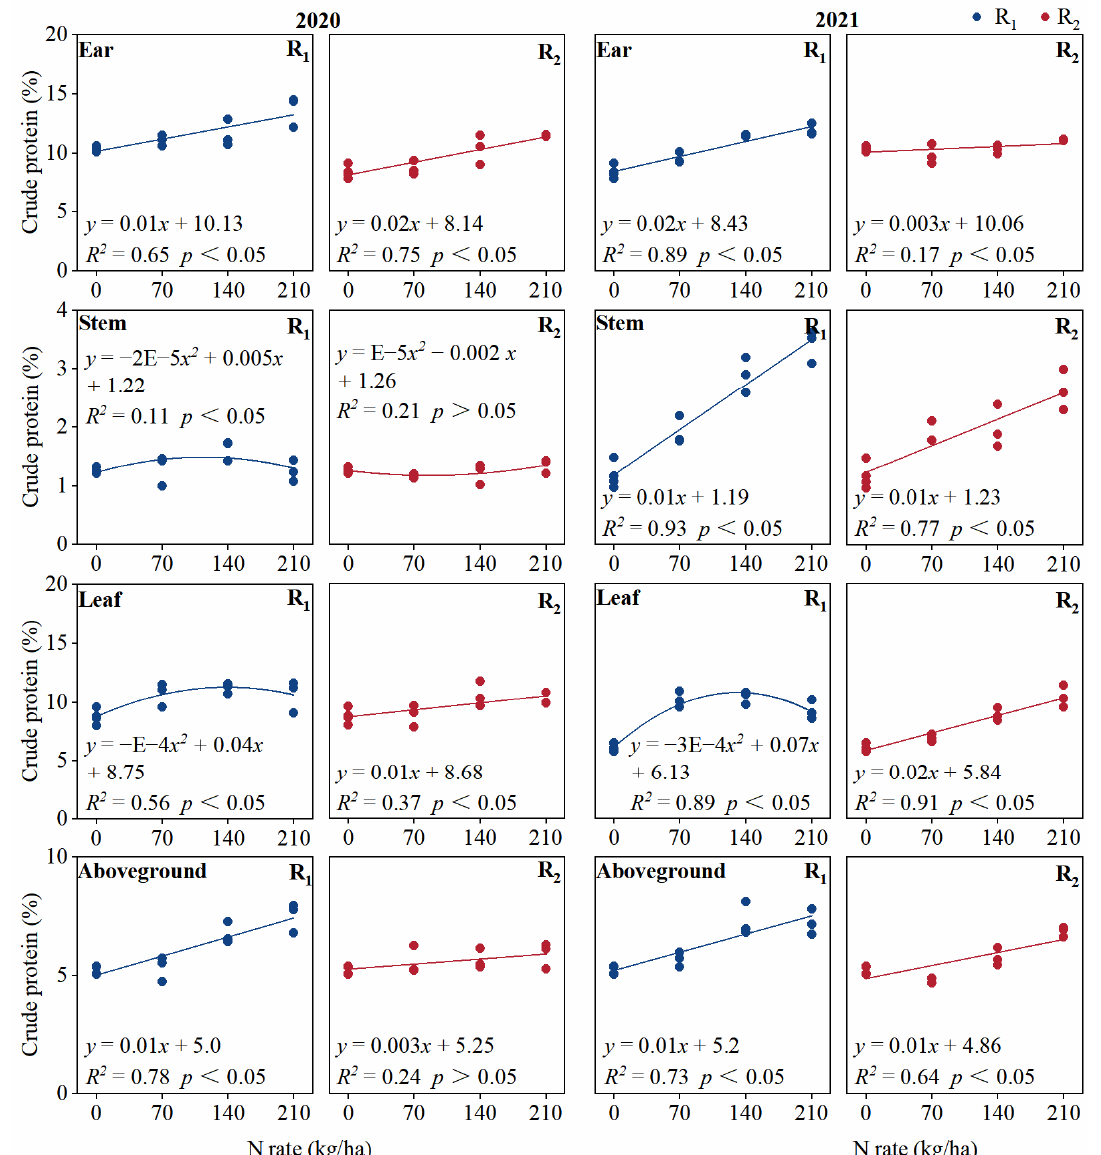
Figure 6. CP content of forage maize at harvest under different treatments in 2020 and 2021. Table 4. Effects of different fertilization rates and basal topdressing ratios on CP content in 2020 and 2021.